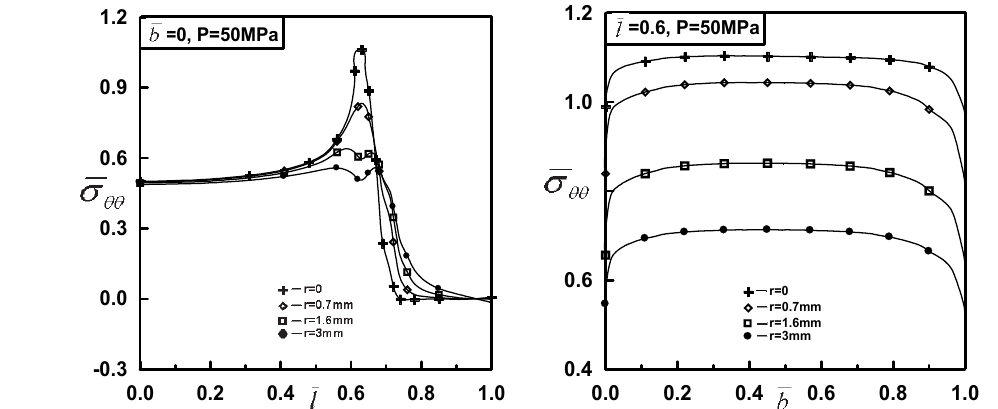
Figure 4: Hoop stress distributions along fillet and